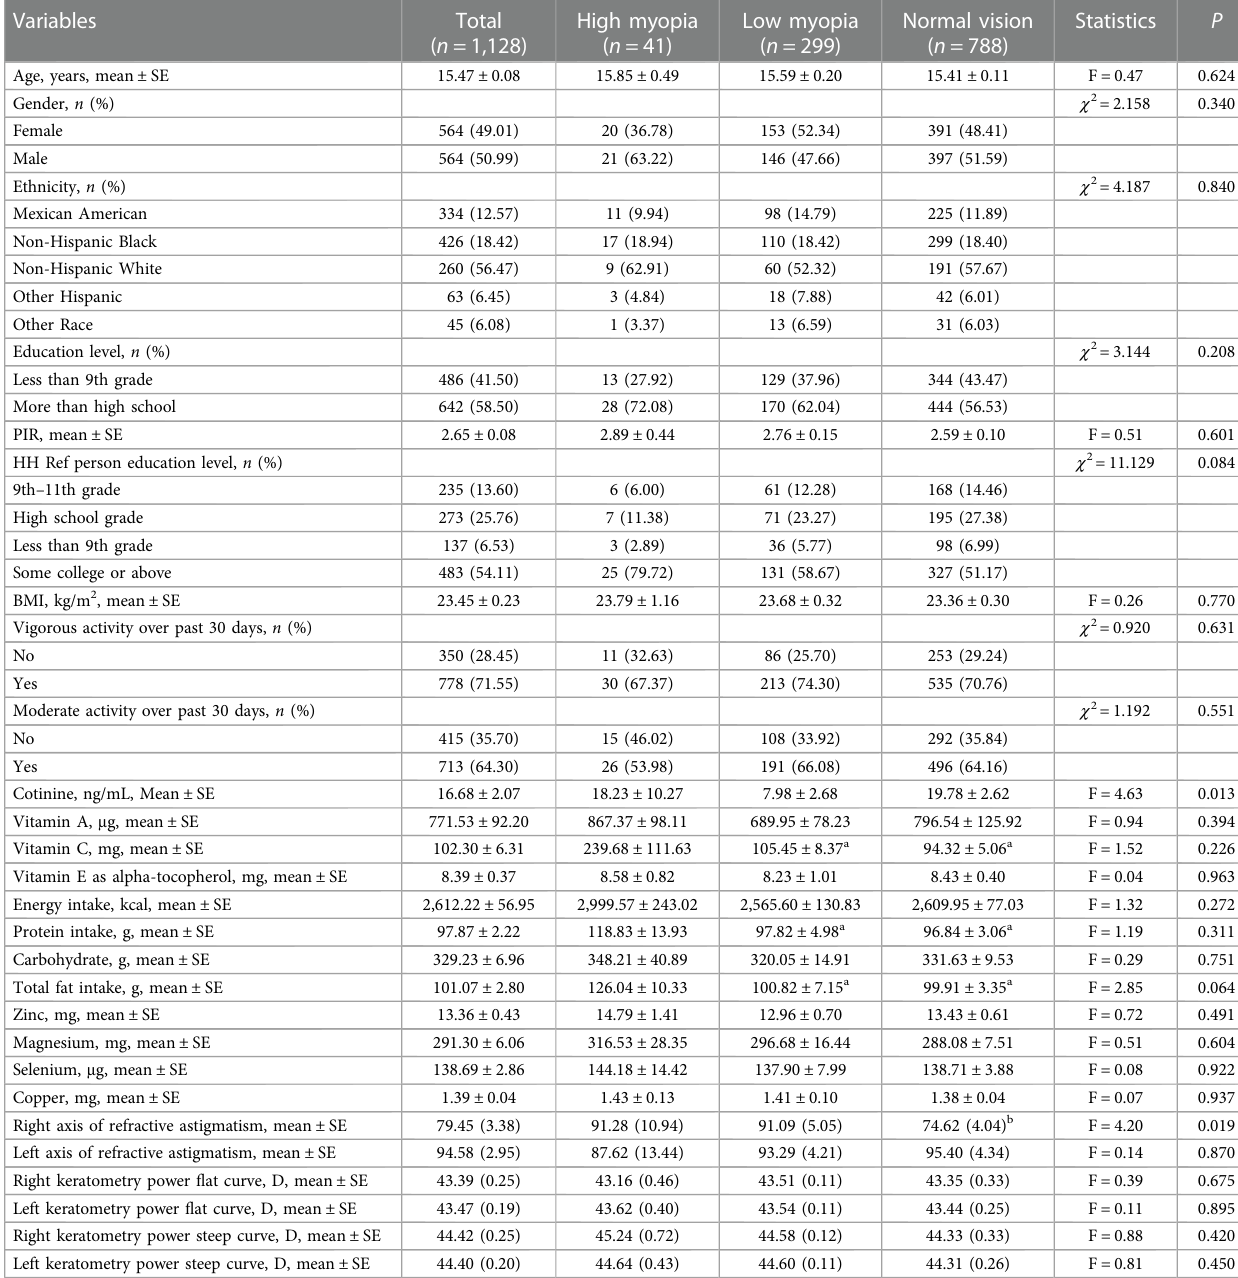
TABLE 1 Characteristics of juveniles with normal vision, low myopia, and high myopia.